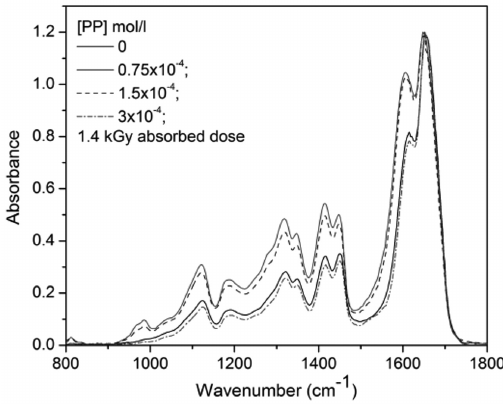
Figure 5. FTIR spectra of samples obtained at 1.4 kGy in range of 650-1800 cm -1 .